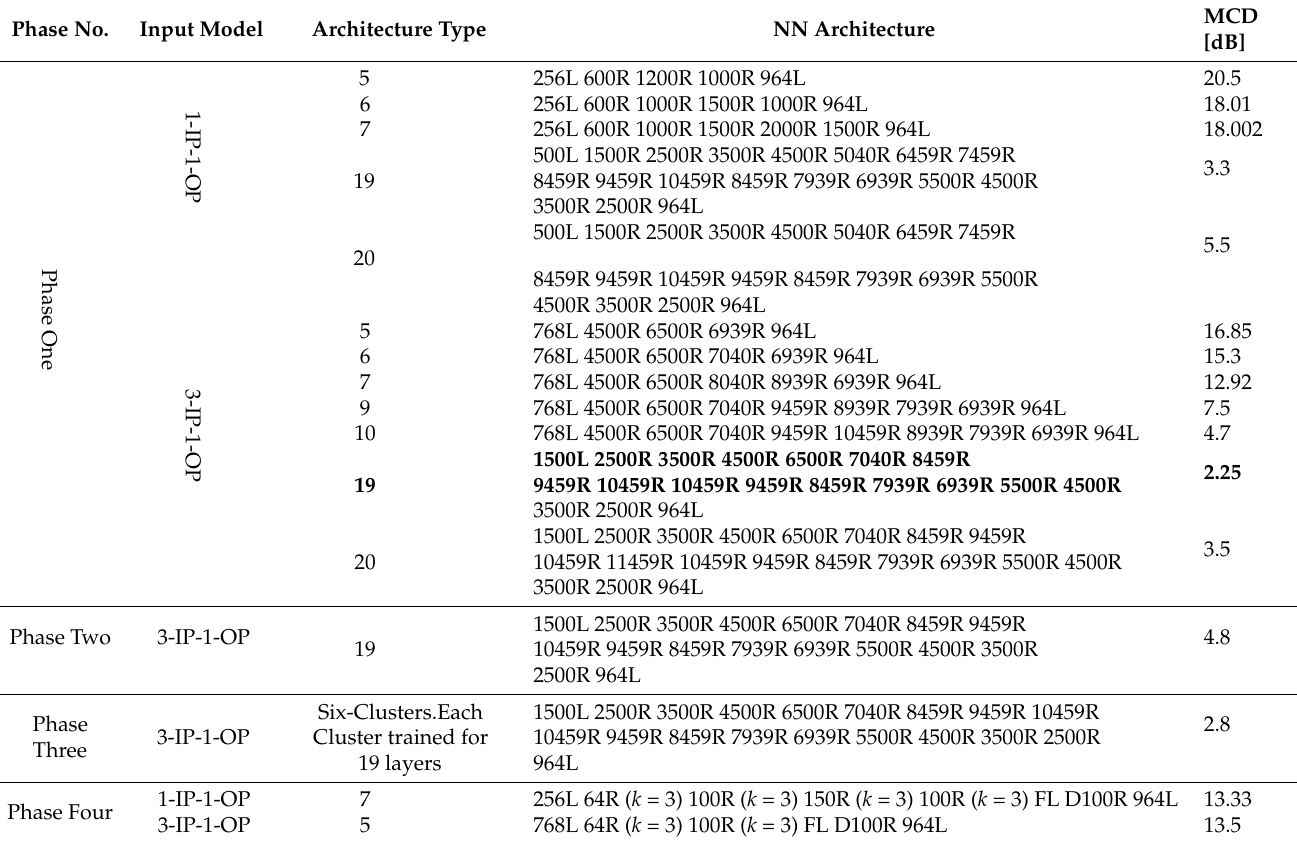
Figure 11. Mean squared error (l curve), phase one. Table 2. MCDs obtained for different